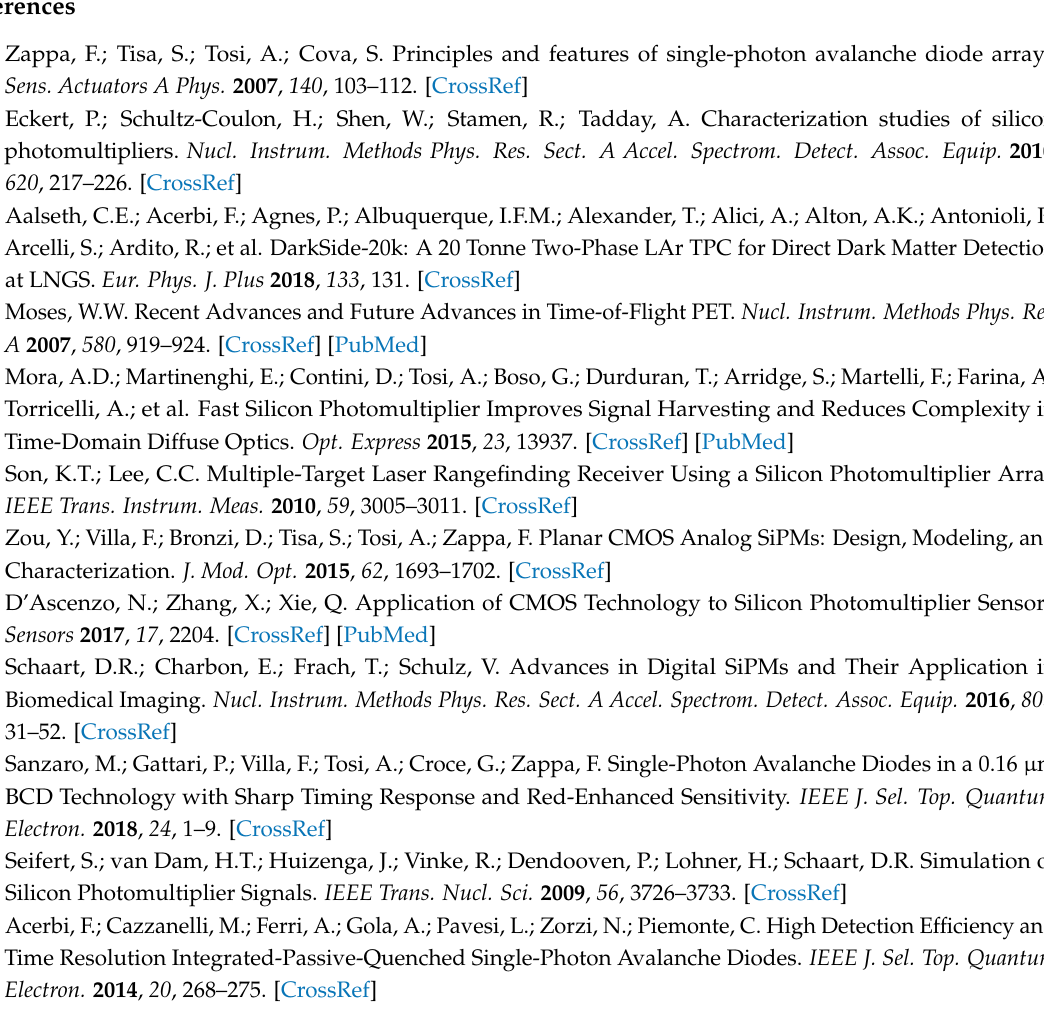
Table 1. Summary of the performance of the developed SiPMs compared to some commercial SiPMs. Device Cells FF (%) SensL C-Series